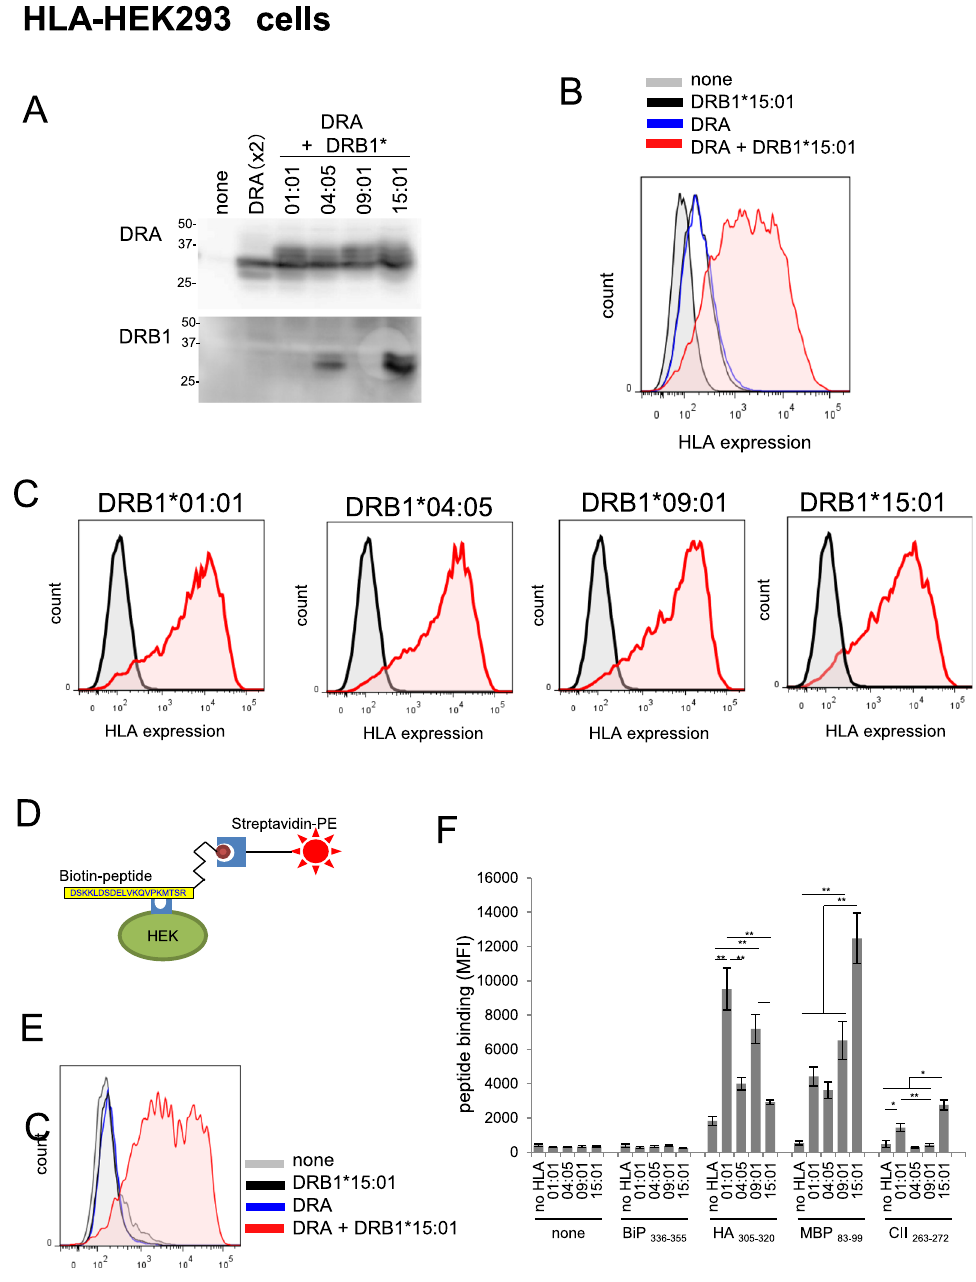
Figure 1. Expression of HLA molecules and binding to various antigen peptides in HEK293T cells. ( A ) Western blot analysis of the expression levels of HLA with anti-DRA or DRB1 antibody. ( B ) FACS analysis of cell-surface expression of DRA molecules after transfection with vector for DRA * 0101, DRB1 * 15:01, or the combination of both. ( C ) FACS analysis of the expression levels of cell-surface HLA molecules in various co-transfected HEK293T cells. HEK293T cells were transfected with a plasmid vector for DRA * 01:01 alone or in combination with the indicated expression vector for DRB1, and HLA protein expression levels in the Triton X-100-soluble fraction ( A ) or intact cell surface ( B and C ) was analysed 24 h later. The grey peak and pink peak represent untransfected control cells and respective DRB1 transfected cells, respectively. For each data, one set of representative result is shown. ( D ) Scheme of FACS analysis of peptide binding to cell-surface HLA molecules. HLA-expressing cells were incubated with biotinylated antigen peptide, and HLA-bound peptides were probed with SA-PE, followed by FACS analysis. ( E ) Specificity of peptide binding. HEK293T cells transfected as in ( B ) were incubated with biotinylated MBP83-99 (30 µ M) for 5 h, and bound peptides were analysed by FACS. ( F ) Summary of relative binding affinity of HLA-DR and epitope peptides. Peptide binding assay was carried out in various HLA-expressing cells as in ( E ) (see, Supplementary Figs 1 and 2). Mean fluorescence intensity was plotted as mean ± inter-assay deviation expressed as SEM from 3 to 6 independent experiments. * P < 0.05 and ** P <